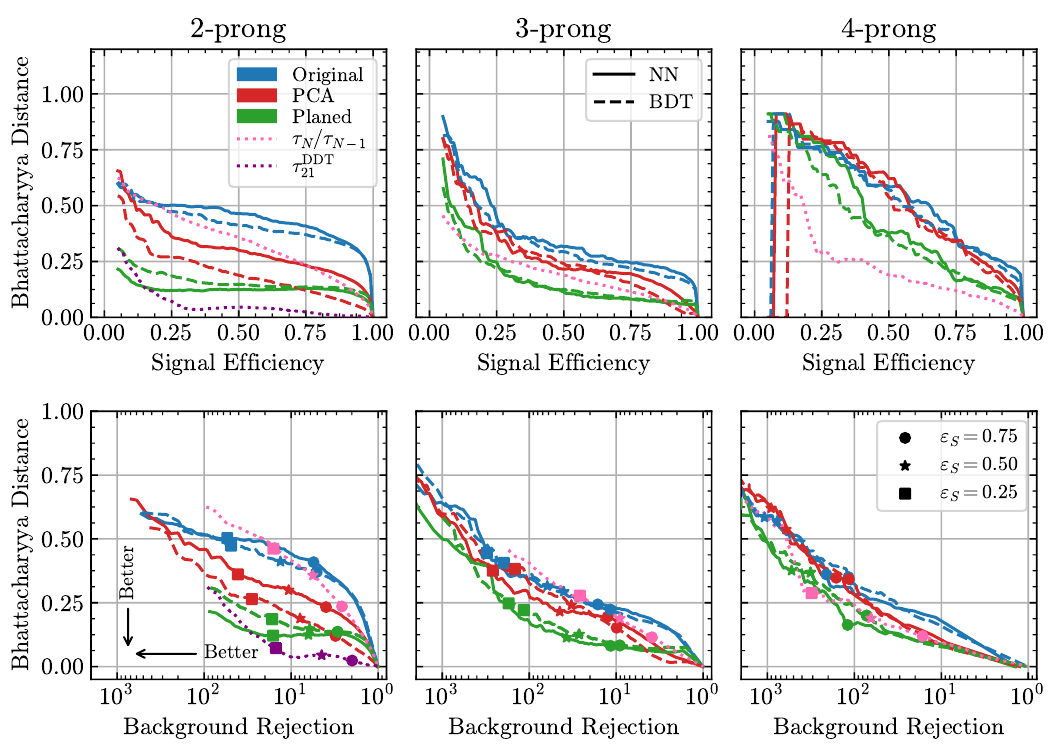
Figure 14: The Bhattacharyya distance for the QCD background distributions com- pared to the original distributions. The distance is defined in Eq. (9), and a larger distance represents more sculpting—lower on the plot is better. The neural networks tend to sculpt the distributions worse than the BDT, regardless of the data. Both the PCA rotations and Planing the jet mass result in smaller distances than the classifiers trained on the original